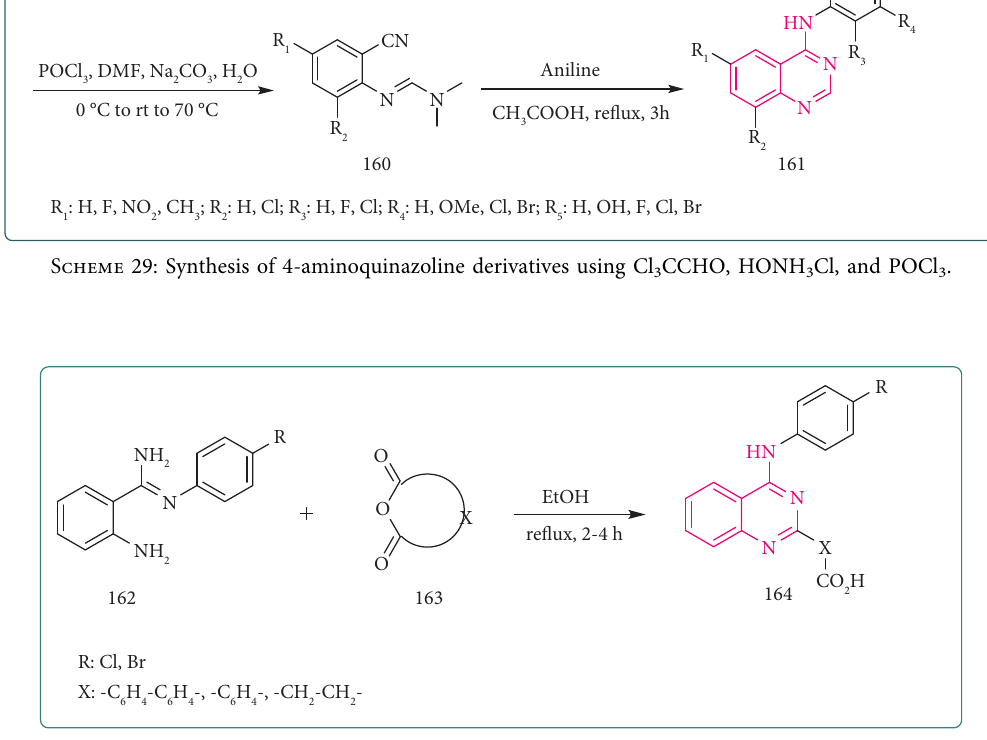
Scheme 30: Synthesis of 4-arylaminoquinazoline-2-carboxylic acid